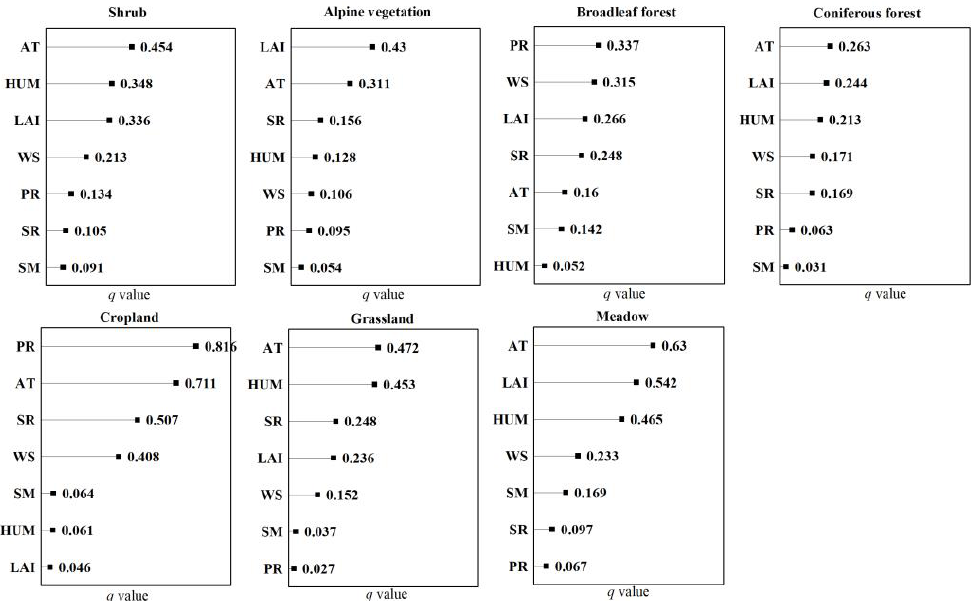
Figure 14. Factor detector-based explanatory power ranking of bio-meteorological variables for WUE in different vegetation types. AT: air temperature; PR: precipitation; HUM: specific humidity; WS: wind speed; SR: shortwave radiation; VT: vegetation type; SM: soil moisture; LAI: leaf area